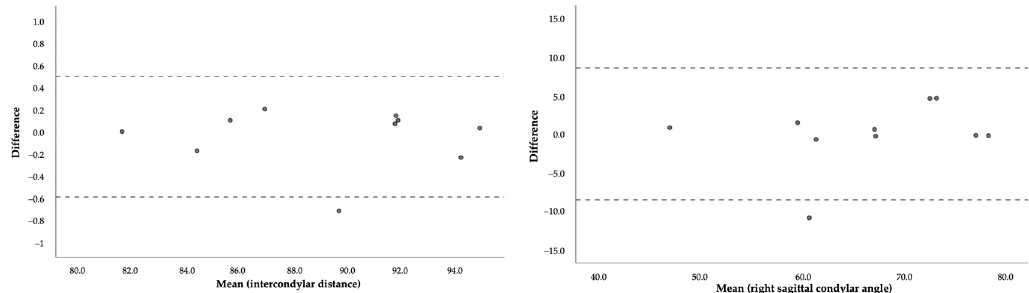
Figure 4. Bland–Altman plots to assess agreement between time points of evaluation.